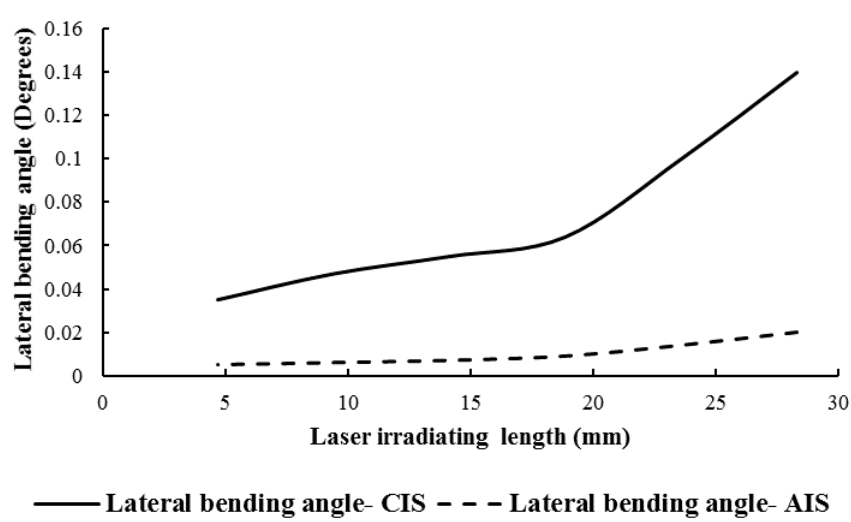
Figure 5. The effects of the circular irradiating scheme (CIS) and axial irradiating scheme (AIS) on the lateral bending angle of the laser-bent tube.